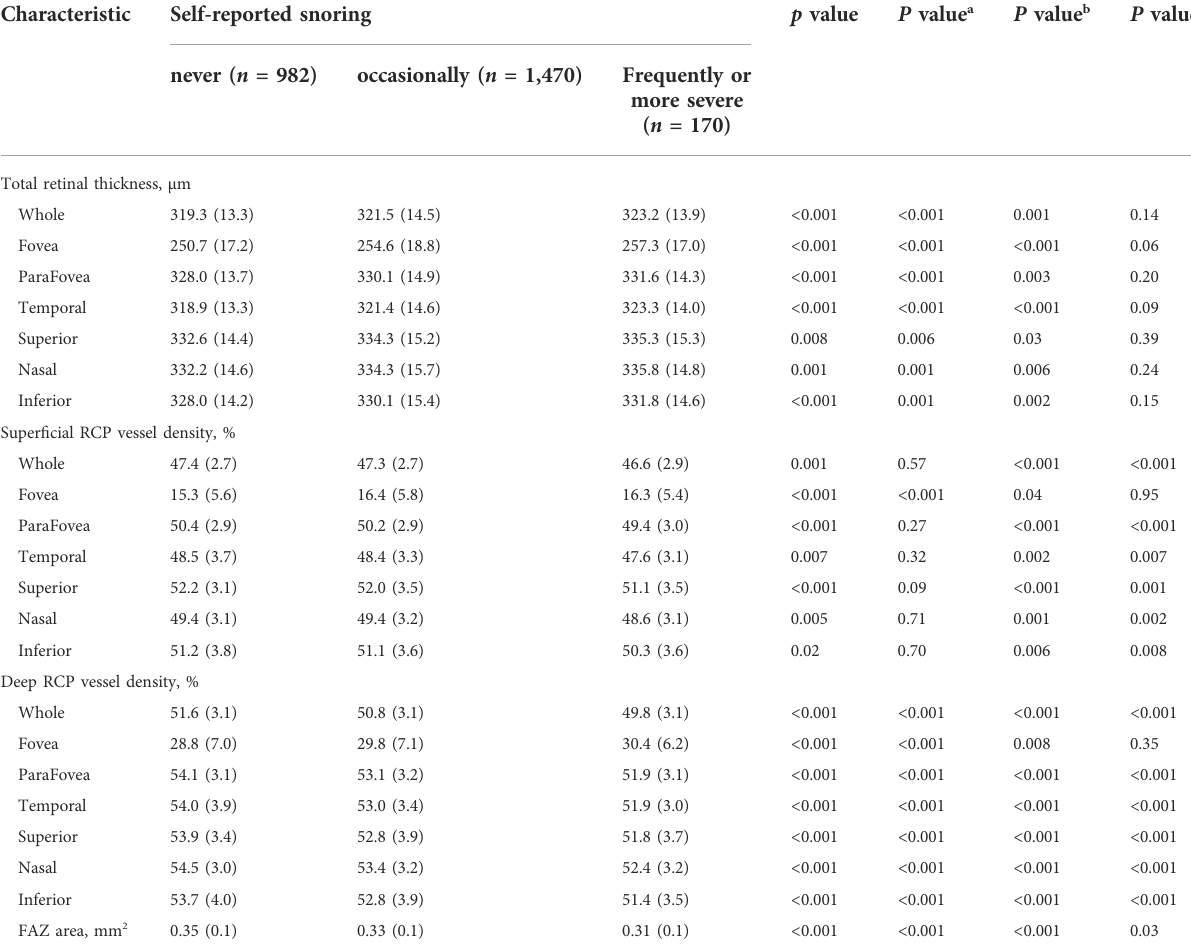
TABLE 2 Ocular characteristics of participants in different frequency of self-reported snoring.